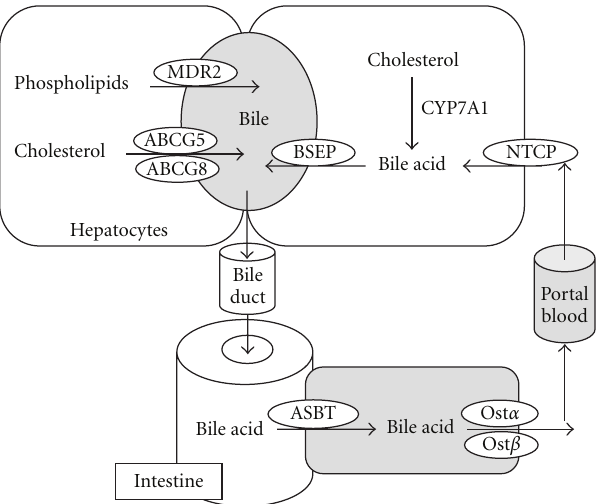
Figure 1: Enterohepatic circulation of the bile. Bile acids are synthe- sized from cholesterol in the hepatocytes. CYP7A1 regulates the rate-limiting step in the classic bile acid biosynthetic pathway. Bile acids are secreted into the gallbladder via BSEP. Phospholipids are transported via MDR2, and cholesterol is transported by the ABCG5/G8 transporters into the bile. In the gallbladder, bile acids, phospholipids, and cholesterol form mixed micelles to solubilize cholesterol and to reduce bile acid toxicity. After meal intake, gall- bladder releases bile into the small intestine where bile acids facil- itate the absorption of dietary lipids and vitamins. At the terminal ileum, most of the bile acids are reabsorbed by ASBT into the en- terocytes, and secreted into the portal circulation via basolateral bile acid transporters Ost α /Ost β . At the basolateral membrane of the hepatocytes, bile acids are taken up by the NTCP transporter for resecretion into the